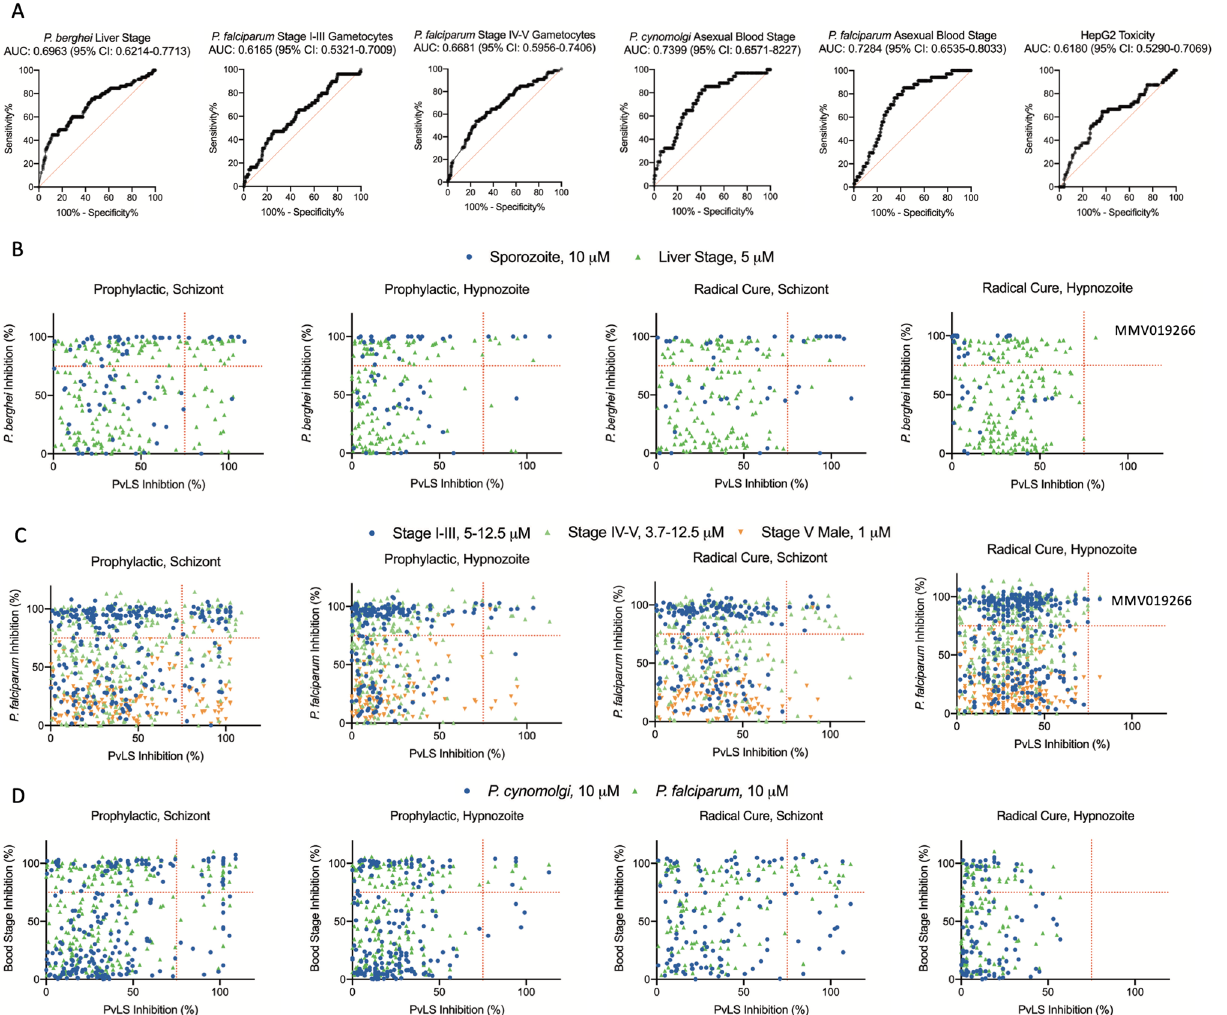
Figure 6. Cross-comparison of Single Point activity data from other Plasmodium species and lifecycle stages. ( A ) ROC curves showing predictive value of other datasets grouped by P. berghei liver stage, P. falciparum Stage I-III gametocytes, P. falciparum Stage IV–V gametocytes, P. cynomolgi asexual blood stage, P. falciparum asexual blood stage and hepatic toxicity. Non-vivax data was combined into a single number for each compound by using the highest inhibition value from the different assays which generated data for that species and stage; PvLS data was combined into a single number by using the highest inhibition value obtained against either hypnozoites or schizonts in either mode, and if any value was > 75%, that compound was deemed “active” (or, for hepatic toxicity, > 9% nuclei loss was deemed “toxic”). Area under curve (AUC) and 95% CI are indicated. ( B – D ) X axis is breakout of hypnozoite and schizont data by mode from ‘A,’ Y-axis is other species or stage activity data, Single Point test concentration is noted in legends. ( B ) Breakout of data P. berghei data from ‘A.’ ( C ) Breakout of P. falciparum gametocyte data from ‘A.’ ( D ) Breakout of P. cynomolgi and P. falciparum blood stage data from ‘A.’ Red lines indicate 75% activity cutoffs. MMV019266, a nonselective false positive, is noted in ( B ) and ( C